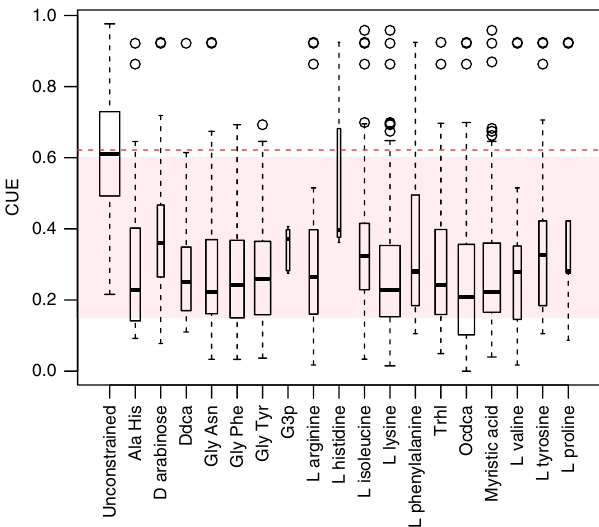
Fig. 1 Potential and substrate-limited CUE. Histogram of predicted potential CUE (purple) and predicted CUE under lysine-limitation (pink) across taxa